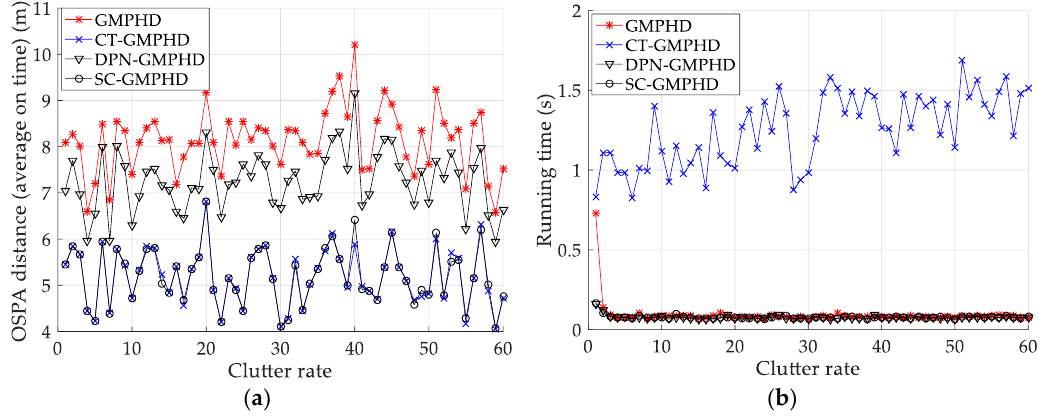
Figure 6. Comparison of tracking performance versus clutter rate: ( a ) average optimal subpattern assignment (OSPA) of the tracking algorithms; ( b ) running time of the tracking algorithms. Table 2. Average OSPA distance and running time of different filters with different clutter rates, for a detection probability of 0.9.